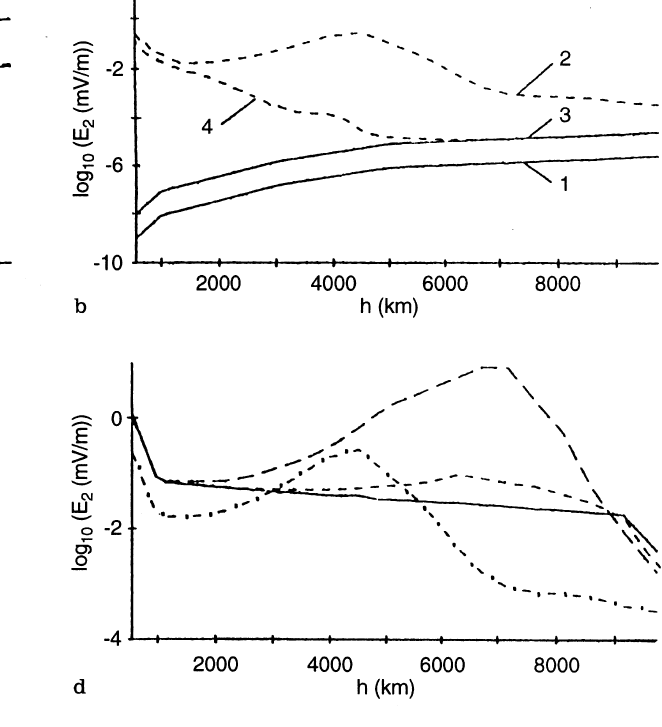
Fig. 4a–e. Electric field strength E 2 parallel to B versus altitude h . In a, b , solid curves represent results calculated omitting anomalous resistivity, dashed curves contain anomalous resistivity. The indices 1 , 2 , ( 3 , 4 ) determine j 2 (cid:136) 10 (cid:255) 6 A/m 2 (cid:133) j 2 (cid:136) 10 (cid:255) 5 A/m 2 (cid:134) . a C (cid:136) 1 : 5 (cid:1) 10 2 s (cid:255) 1 , W = (cid:133) n 2 k B T 2 (cid:134) (cid:136) 10 (cid:255) 2 . b C (cid:136) 1 : 5 (cid:1) 10 (cid:255) 3 s (cid:255) 1 , W = (cid:133) n 2 k B T 2 (cid:134) (cid:136) 10 (cid:255) 3 ; c, d represent the same plasma conditions as Fig. 2c, e (cid:133) W = (cid:133) n 2 k B T 2 (cid:134) (cid:136) 10 (cid:255) 4 , j 2 (cid:136) 10 (cid:255) 6 A/m 2 (cid:134) and Fig. 2d, f (cid:133) W = (cid:133) n 2 k B T 2 (cid:134) (cid:136) 10 (cid:255) 3 , j 2 (cid:136) 10 (cid:255) 6 A/m 2 (cid:134) respectively. The di(cid:128)erent forms of lines correspond to di(cid:128)erent values of C as explained in Fig. 2c–f. e is for W (cid:136) 0 ; j 2 (cid:136) 10 (cid:255) 6 A/m